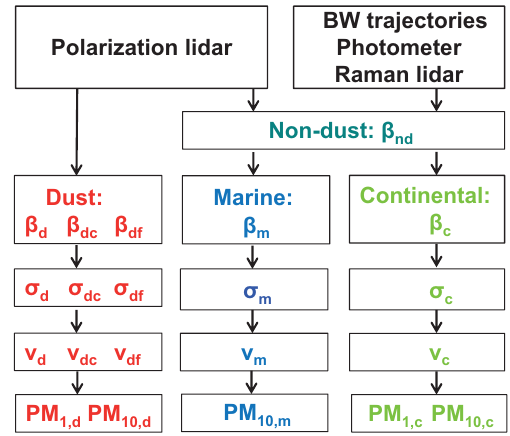
Figure 1. Overview of the POLIPHON data analysis. The depo- larization ratio measurement enables us to separate the backscat- ter coefficients of fine dust, β df , coarse dust, β dc , and of the non- dust aerosol component, β nd . The non-dust backscatter coefficients are subsequently analyzed by using backward trajectories, auxiliary spectrally resolved photometer observations, and, if available, Ra- man lidar observations of the total particle extinction coefficient to identify and quantify the contribution of marine particles ( β m ) and continental aerosol pollution ( β c ) to the total particle backscatter coefficient. The backscatter coefficients β i are converted to parti- cle extinction coefficients σ i , which in turn are converted to profiles of particle volume concentrations v i . Finally, the respective parti- cle mass (PM) concentrations for fine particles, PM 1 ,i , and for fine + coarse particles, PM 10 ,i , can be calculated. Non-dust continental particles are mostly fine-mode aerosol so that PM 1 , c is obtained,